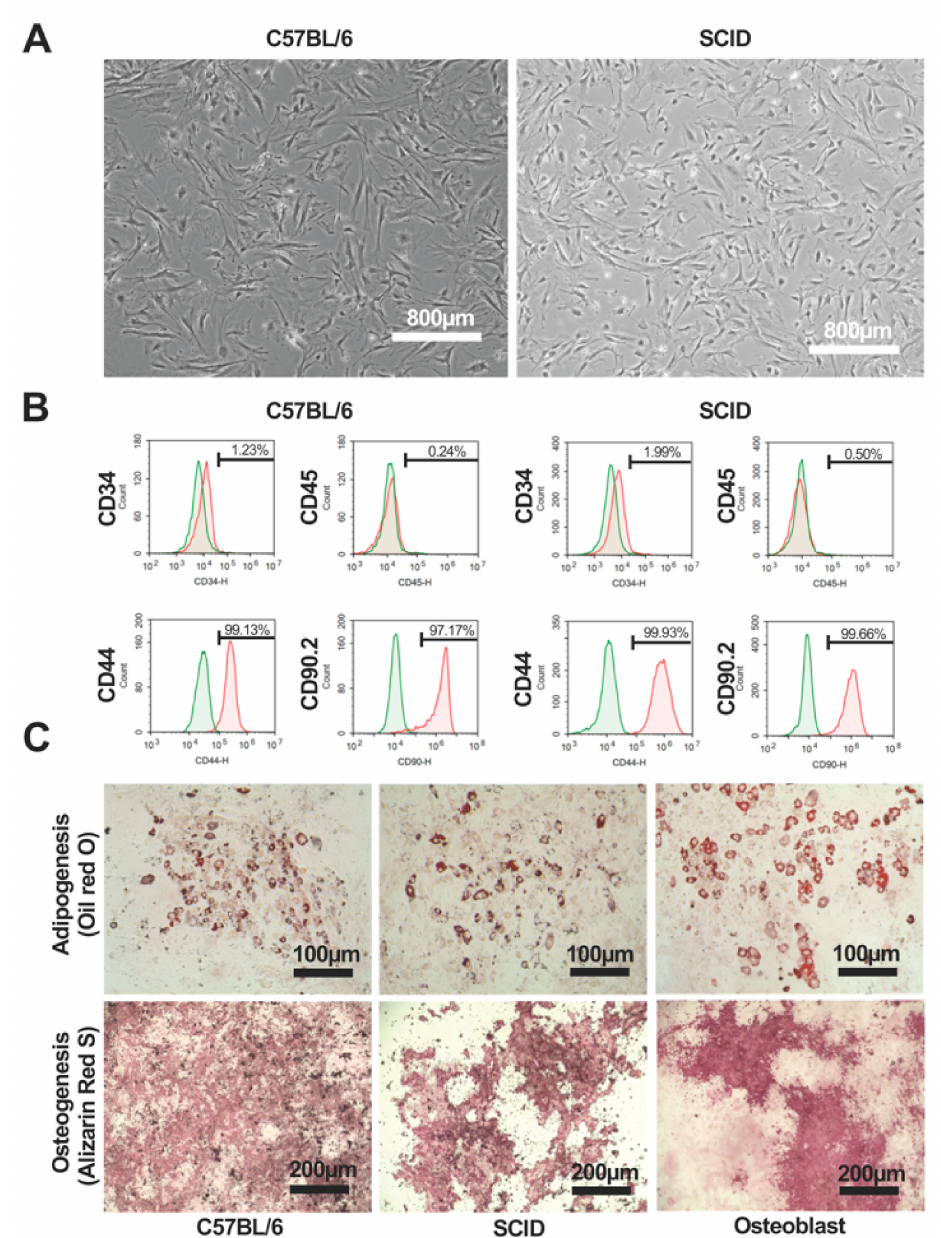
(Figure 1C, lower-middle panel) mAdMSCs and the differentiation of osteoblasts (Figure 1C, lower-right panel) into osteocytes. Mature adipocytes and osteocytes were stained with Oil Red O and Alizarin Red S, respectively.